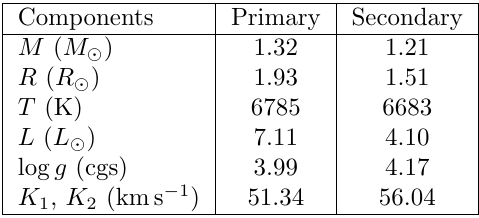
Table 3: Absolute astrophysical parameters of the IO Com